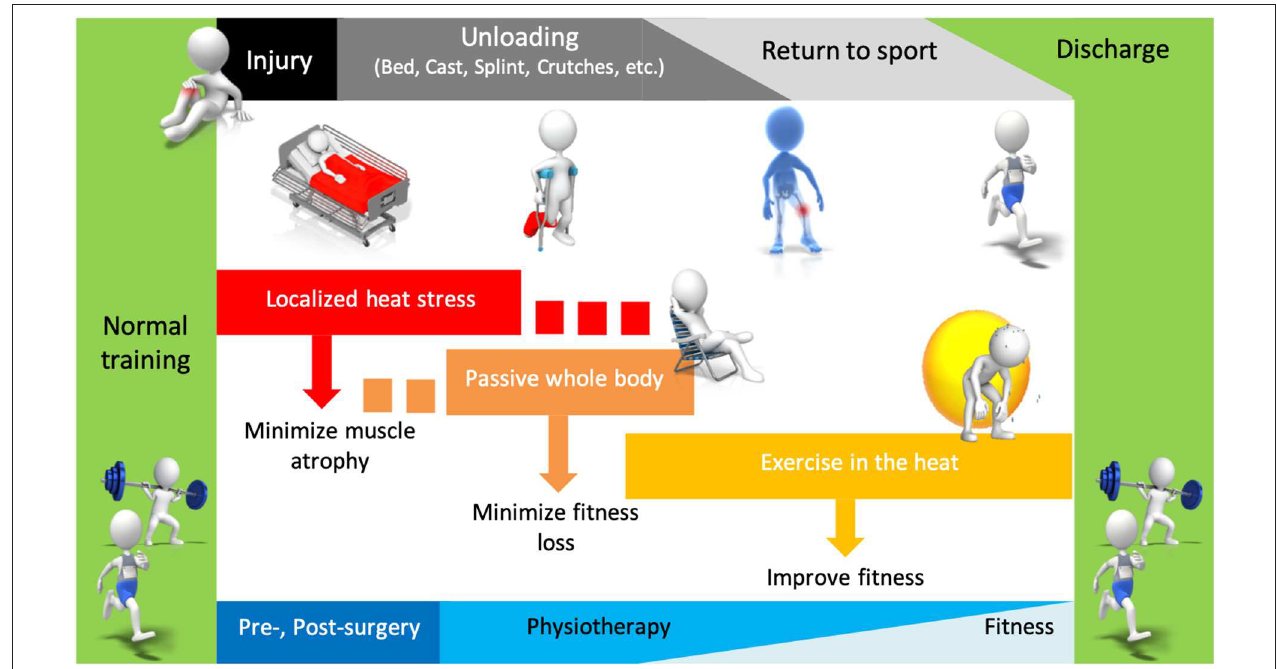
FIGURE 1 | Depiction of how the therapeutic use of passive or active heat stress may be utilized at different stages of rehabilitation to limit muscle atrophy and decline in fitness, optimizing the return to sport.